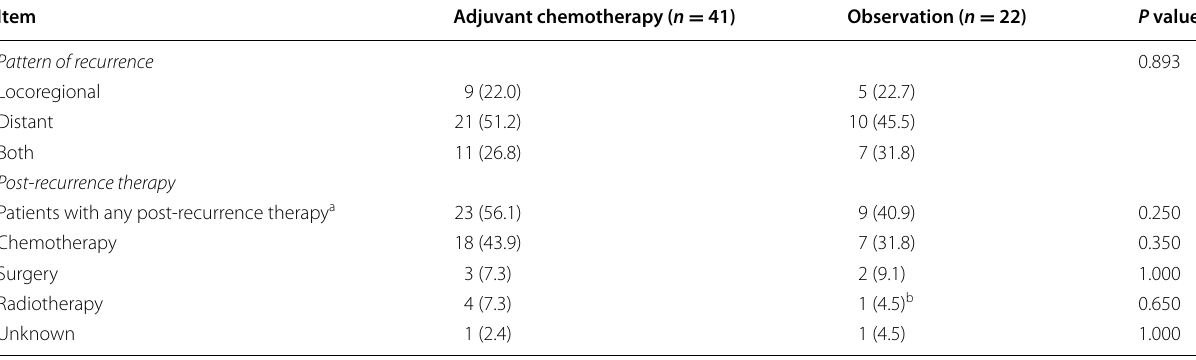
Table 2 Comparison of patterns of recurrence and post-recurrence therapies between two groups of BTC patients under- going R0